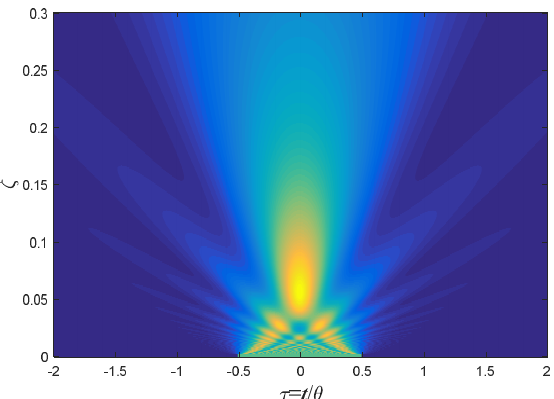
Figure 6. The real (upper panel) and imaginary (lower panel) components of the rectangular pulse (Equation (27)). The dashed curve represents the initial profile (for ζ = β 2 z / θ 2 = 0), while the solid curve represents its final shape (for ζ = β 2 z / θ 2 = 0.01 on the right and ζ = β 2 z / θ 2 = 0.3 on the left). In Figure 7, a spatiotemporal intensity plot (as a function of τ and ζ ) is presented.